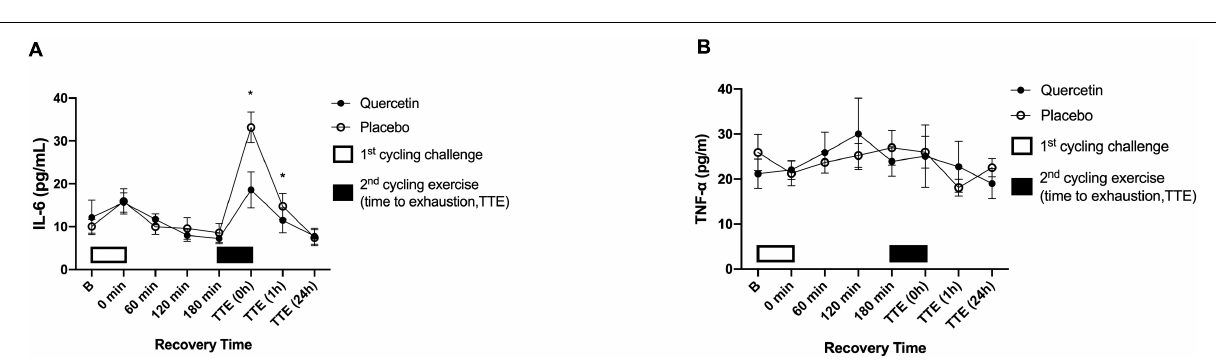
FIGURE 6 | Serum interleukin-6 (IL-6) (A) and tumor necrosis factor- α (TNF- α ) (B) concentrations in (- ◦ -) placebo and (- • -) quercetin trials. B represents before the first cycling challenge. TTE (0 h, 1 h, 24 h): represents immediately, 1-h, and 24-h after the second cycling exercise, respectively. *Significant difference between quercetin and placebo ( p < 0.05). Values are expressed as mean ± SE, N =